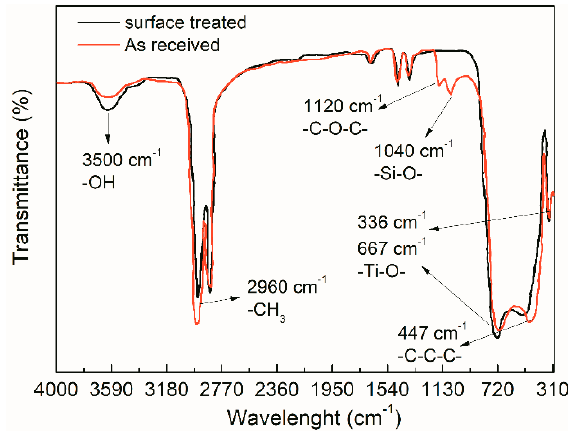
Figure 3. FTIR results of as received and modified TiO 2 nanoparticles.